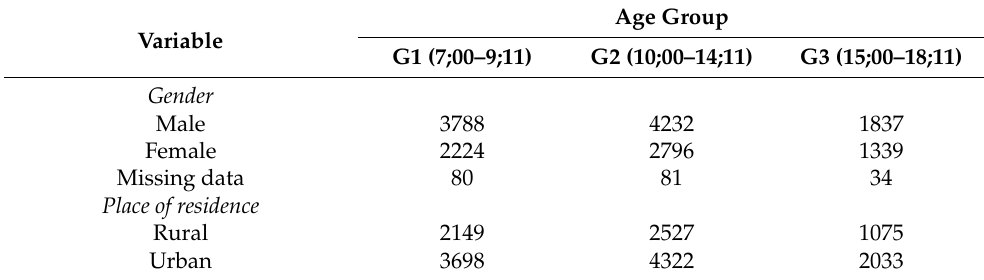
Table 1. Composition of the